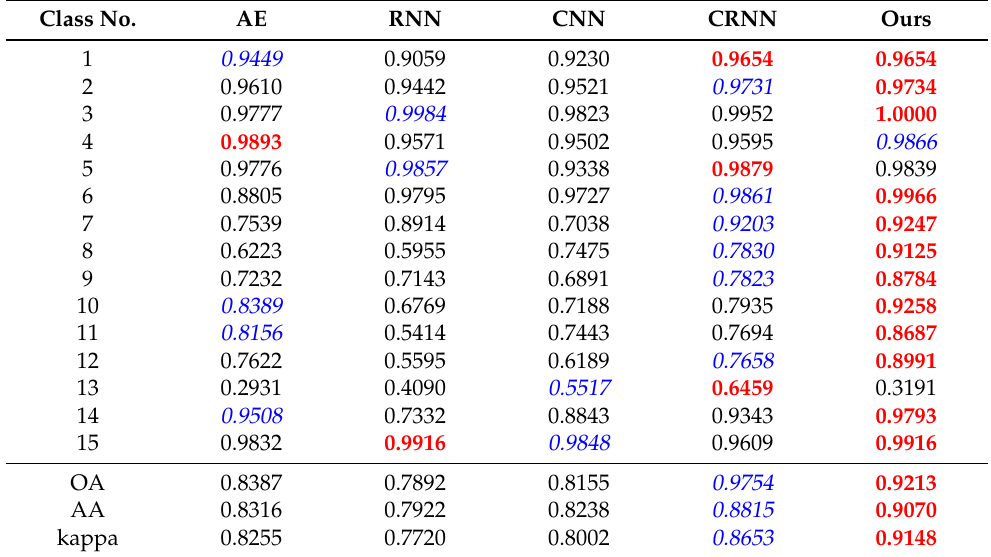
Table 5. Classification Results for Imbalanced Data on Houston 2013. The red bold fonts and blue italic fonts indicate the best and the second best